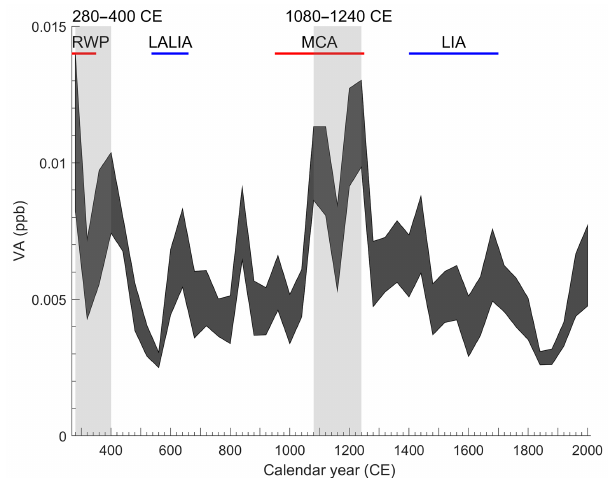
Figure 3. Tunu ice core VA record. The gray-filled lines are ± 1 standard error of the 40-year bin averages of the data. The horizontal lines show the Roman Warm Period (RWP), Late Antique Little Ice Age (LALIA), Medieval Climate Anomaly (MCA), and the Little Ice Age (LIA) (Büntgen et al., 2016; Mann et al., 2009; Wang et al., 2012). Light gray shaded areas are elevated periods in the record.